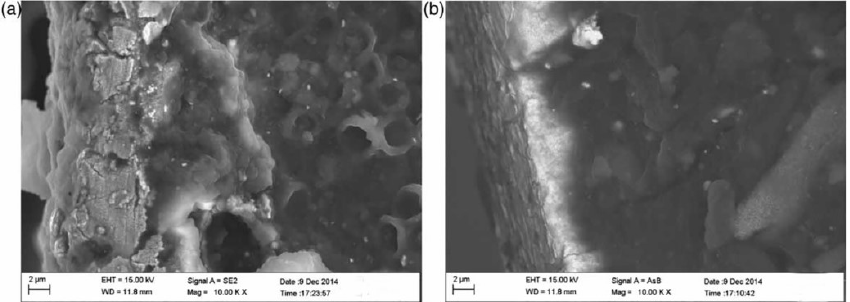
Figure 7. Surface morphology of IPMC composite electrode observed by SEM. ( a ) IPMC electrode surface without MWCNTs. ( b ) IPMC electrode surface with MWCNTs added